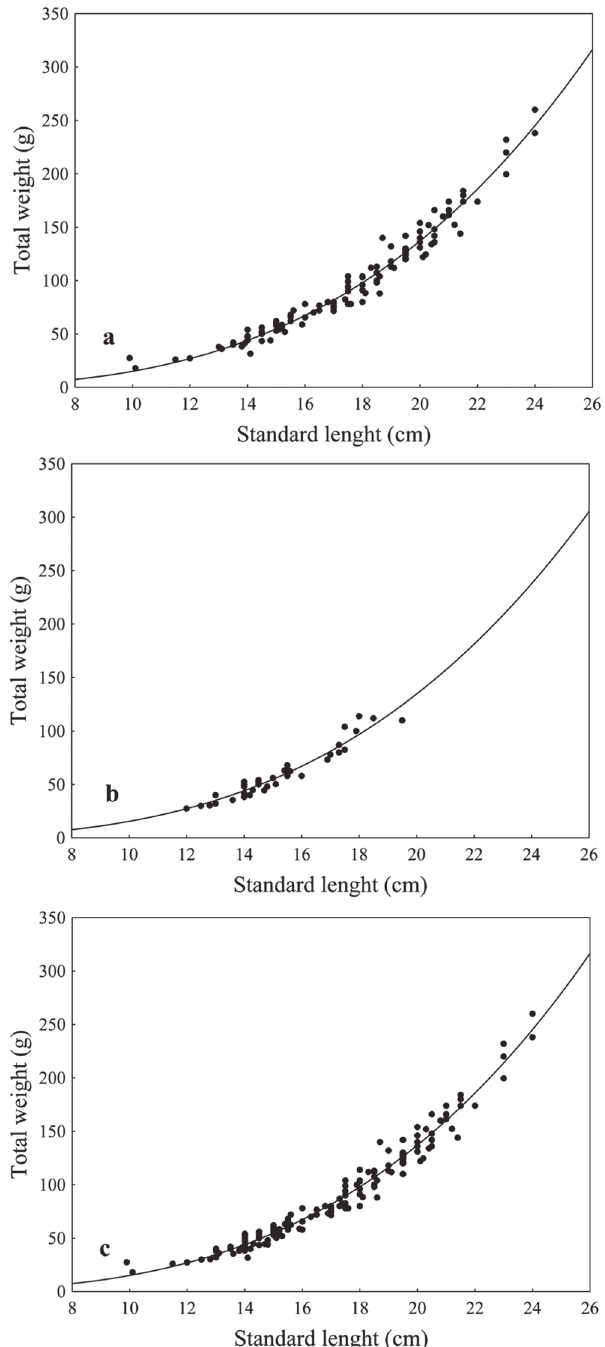
Fig. 4 . Length/weight relationship for females (a), males (b) and for both sexes (c) of Iheringichthys labrosus , obtained between November 2002 and September 2003 in the Piquiri